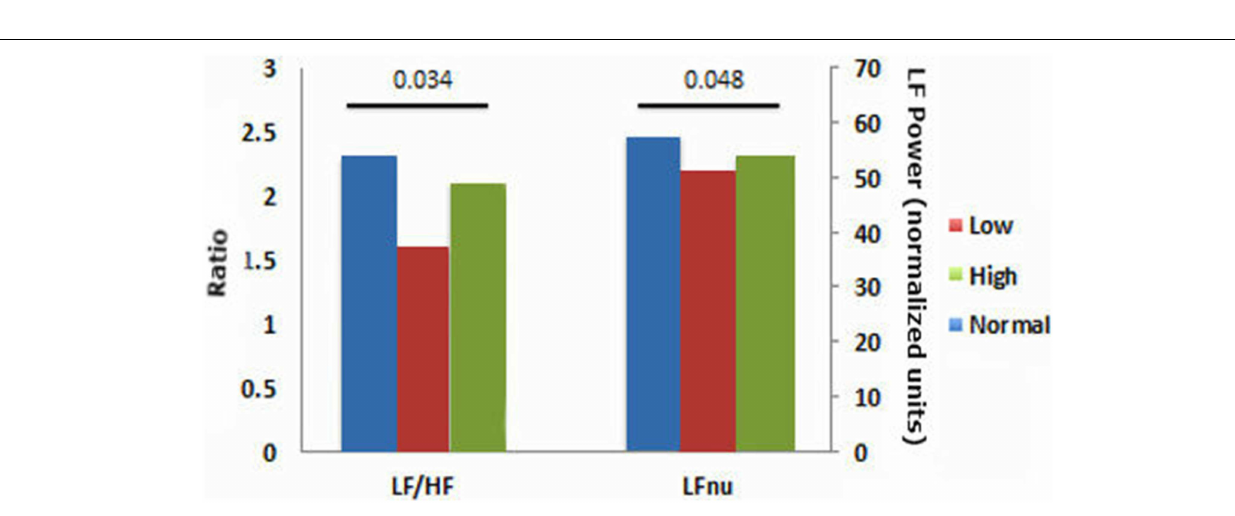
FIGURE 3 | Time and frequency domain HRV results comparing normal, low and high APBI